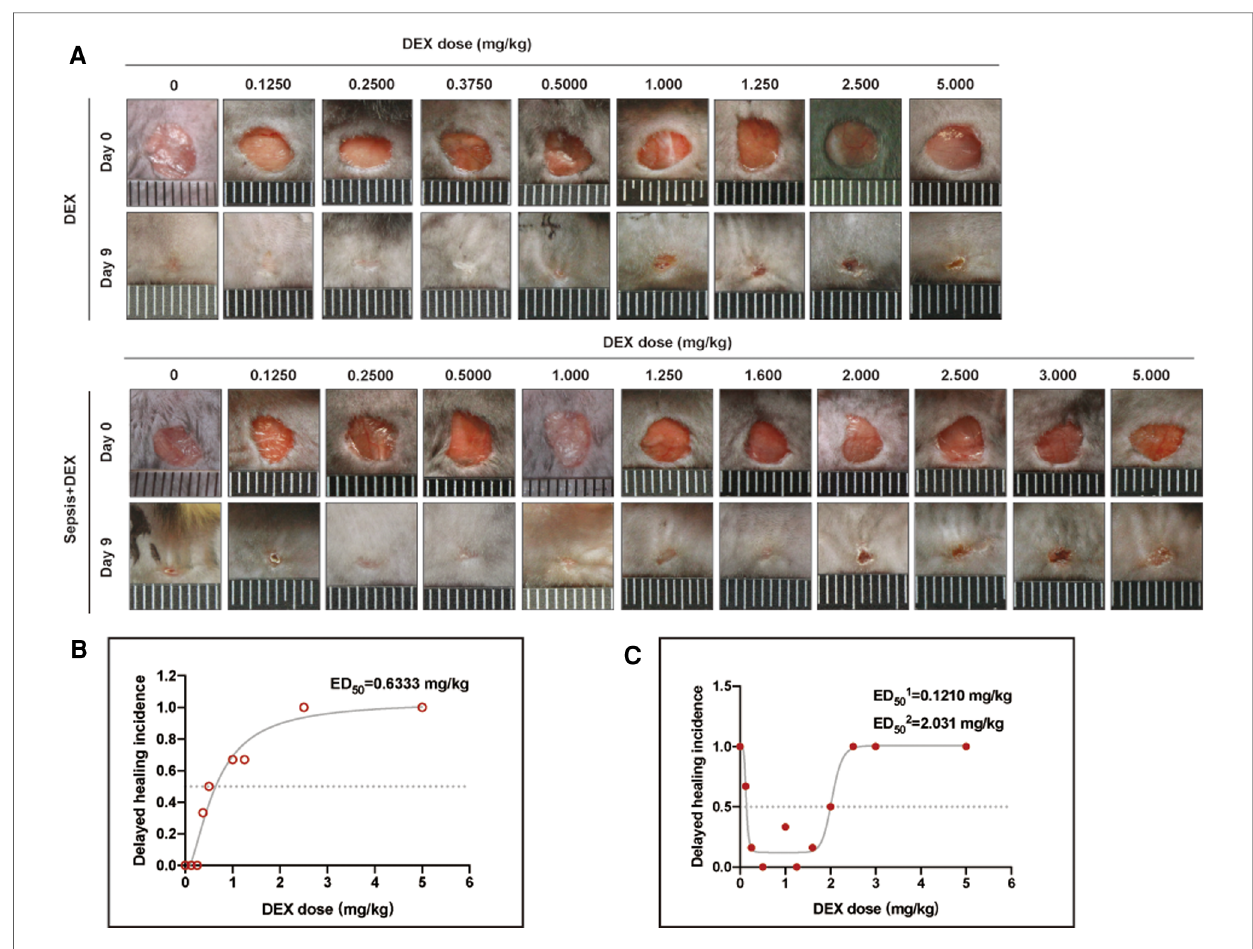
FIGURE 2 Dose curves of dexamethasone for wound healing in mice with and without sepsis. ( A ) Appearance of wounds on days 0 and 9 for DEX and sepsis+DEX groups. ( B ) Dose curve of dexamethasone for wound healing in normal mice. R 2 is 0.959. ( C ) Dose curve of dexamethasone for wound healing in septic mice. R 2 is 0.958. In ( B,C ), the non-healing wound was de fi ned as that wound closure rate on day 9 was less than 90.1%. Parameter values are presented in Tables 2 , 3 .